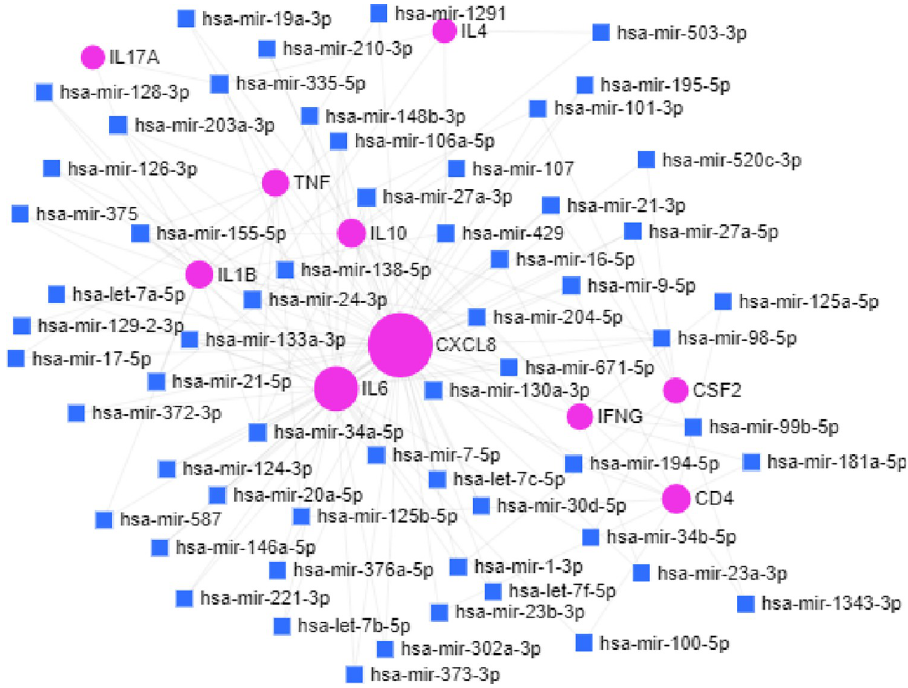
Fig 4. Target-miRNA interaction network constructed in miRNet online tool. Green nodes represent the target genes, and blue nodes represent miRNAs.